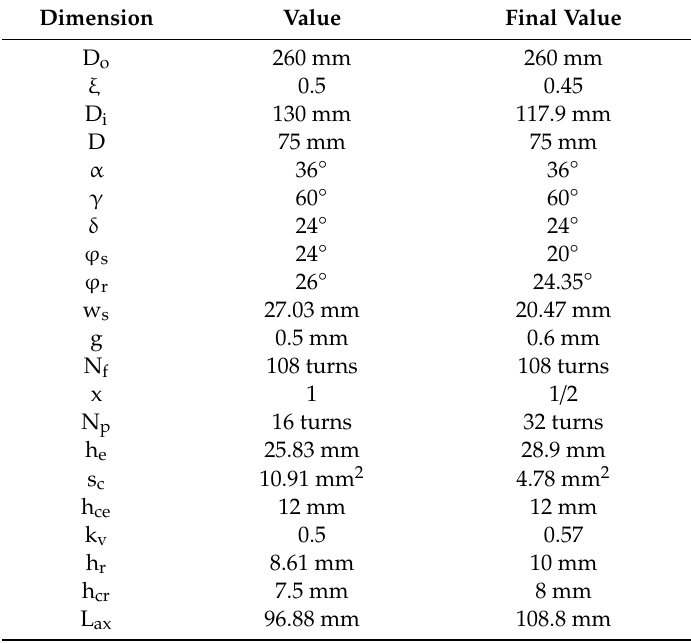
Table A1. Main dimensions and parameters of the AFSRM